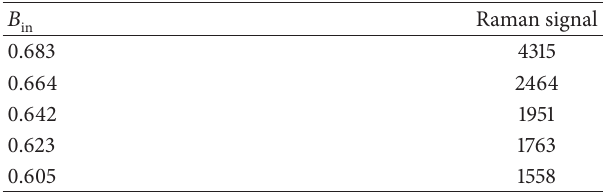
Table 2: Raman signal of Staphylococcus aureus at 723 cm −1 in ( 𝐵 is the ratio of Staphylococcus aureus different values of 𝐵 in in trapped inside the